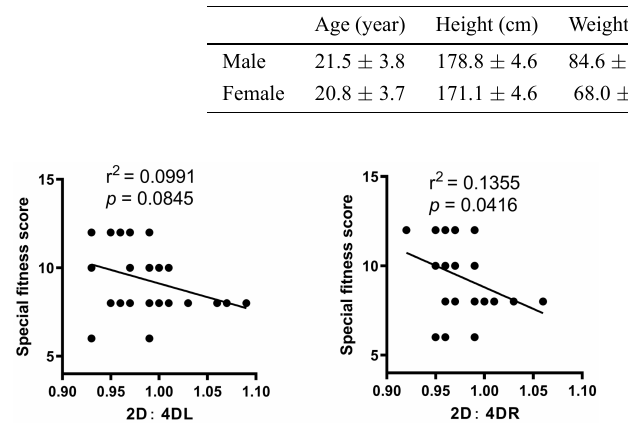
Fig. 2. The correlation between 2D:4D and physical fitness test results.